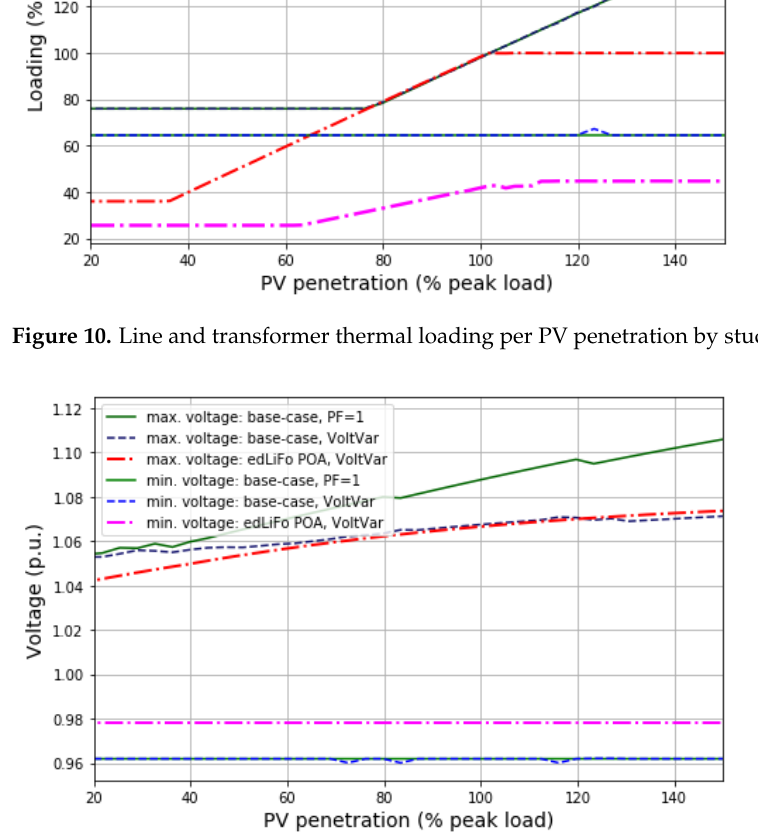
Figure 10. Line and transformer thermal loading per PV penetration by study case.